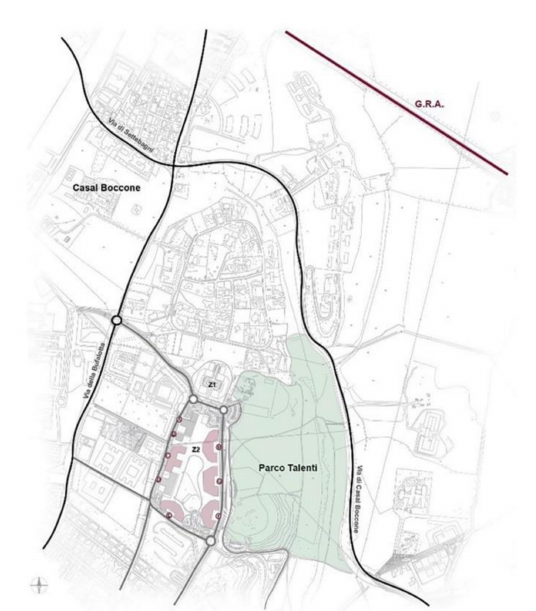
Figure 2. Master plan of the considered area (Rinascimento III) in Rome.